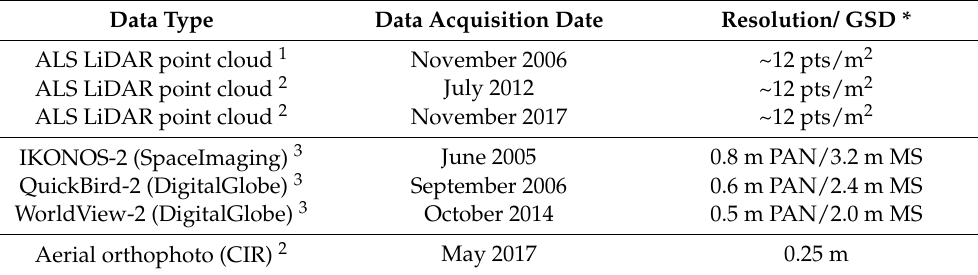
Table 1. Details of the geospatial data acquired.